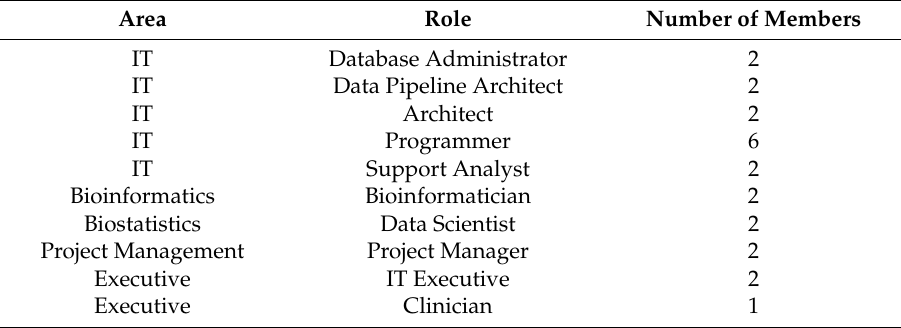
Table 1. Mayo Oracle Translational Research Center (TRC) implementation